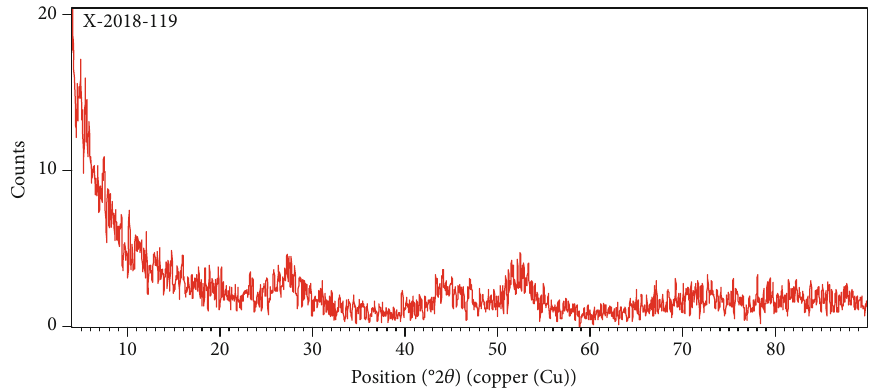
Figure 3: X-ray di ff raction (XRD) pattern of the cadmium sul fi de nanoparticles biosynthesized by Aspergillus niger (RCMB 002002). Start position ( ° 2 θ ): 4.0100; end position ( ° 2 θ ): 89.9900; step size ( ° 2 θ ): 0.0200; scan type: continuous; anode material: Cu-K-alpha1 (Å): 1.54060; generator settings: 40 mA, 40